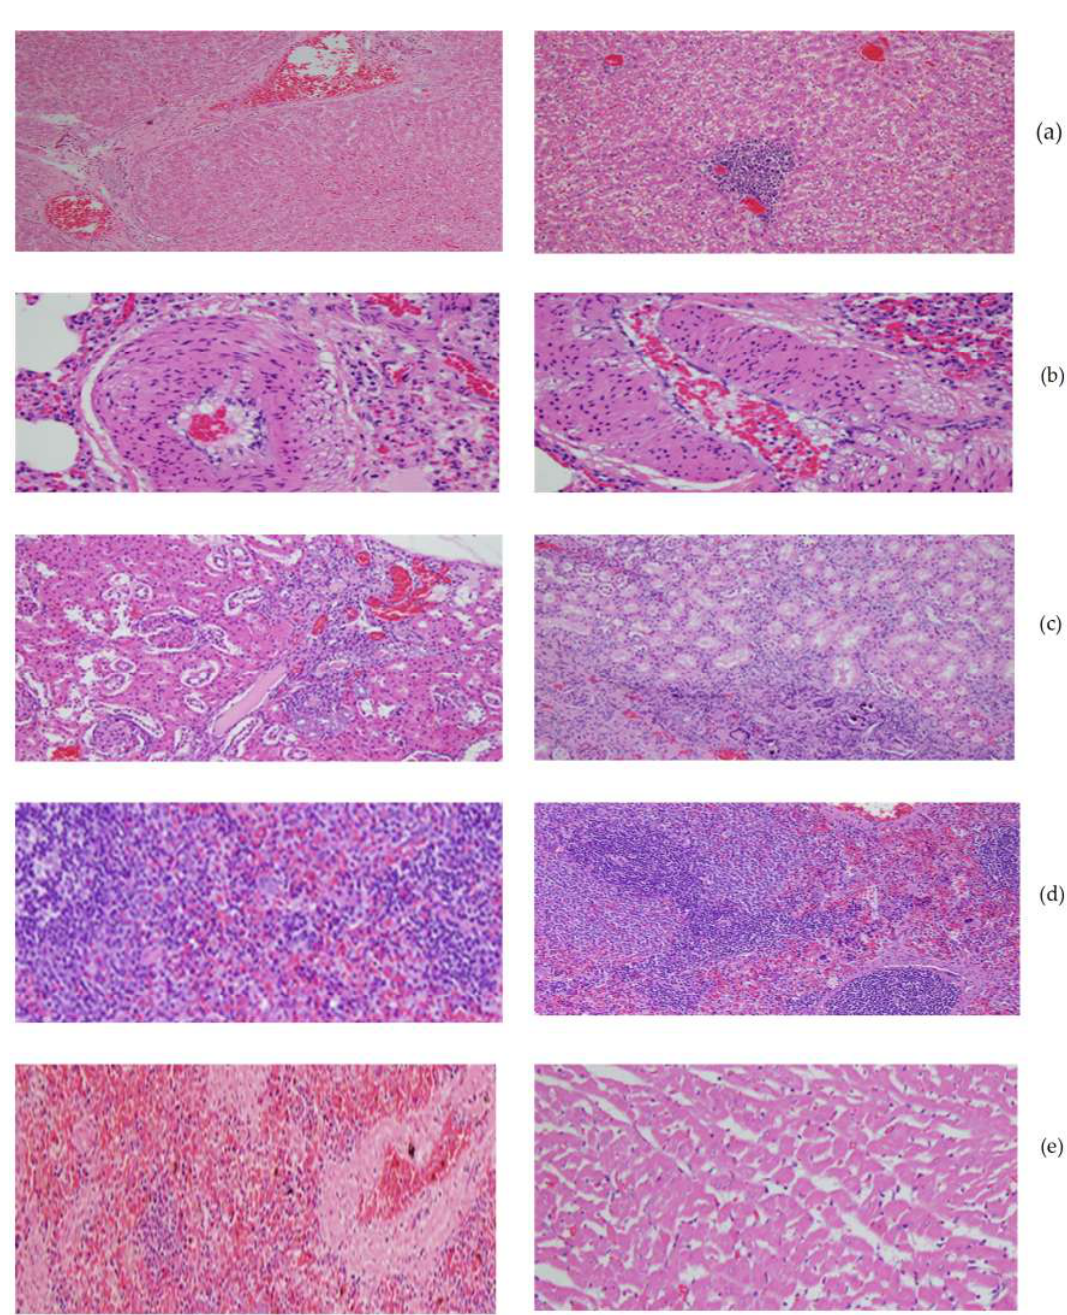
Figure 3. Histological examinations of liver ( a ), lung ( b ), kidney ( c ), spleen ( d ), and heart ( e ) (schedule in 200 µm) from representative male rats treated with vehicle (control) or palm puree. Effects of 2000 mg kg −1 palm puree on various organs in a subchronic oral toxicity study. Top: organ (200 ×) and respective control group shown.